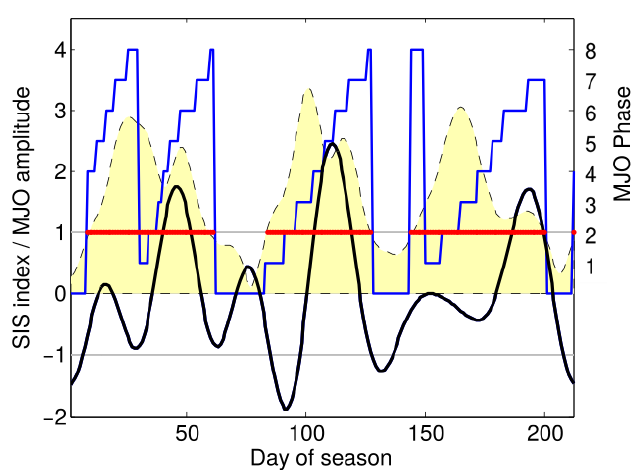
Figure 1. SIS index for the October-April season of 1985/1986 (black line), MJO amplitude (dashed line, yellow shading), MJO phase (blue line). The red dots indicate the fulfillment of the conditions of an MJO event as defined in Section 2.